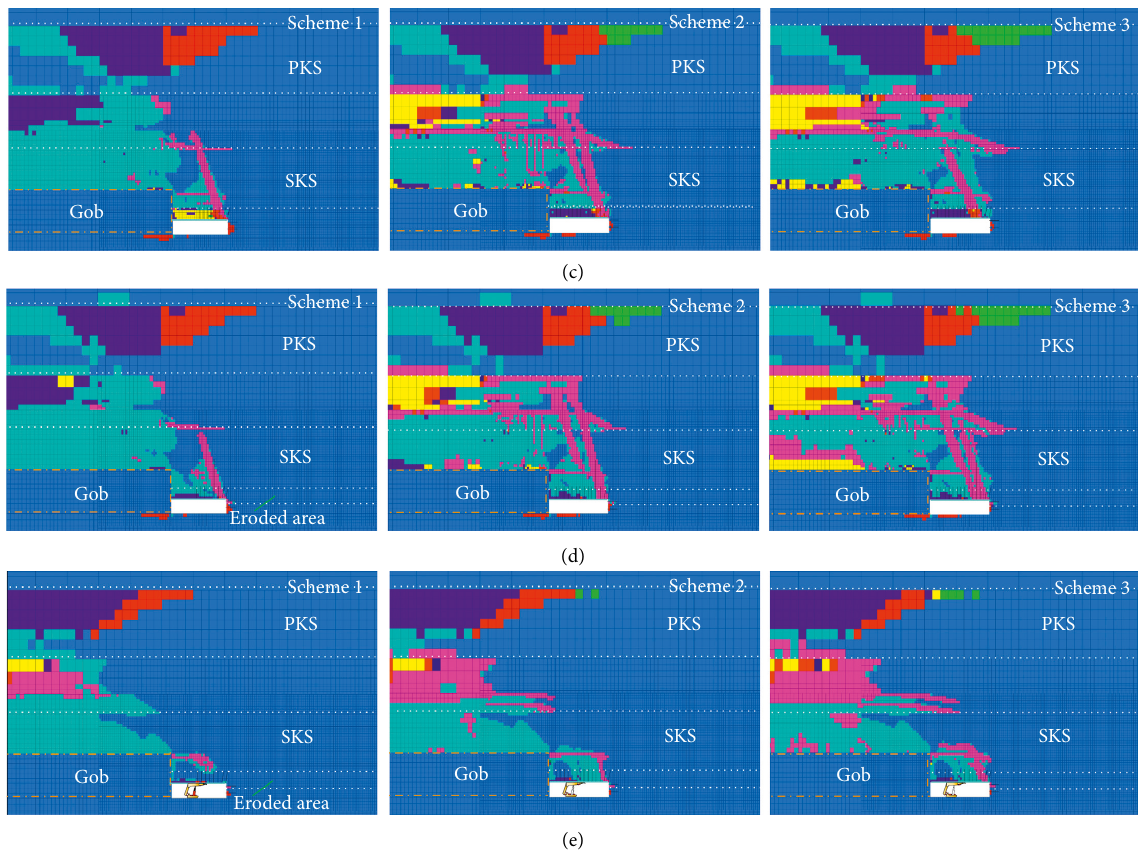
Figure 22: Plastic zone distribution of Stage III. (a) I-I. (b) II-II. (c) III-III. (d) IV-IV. (e)